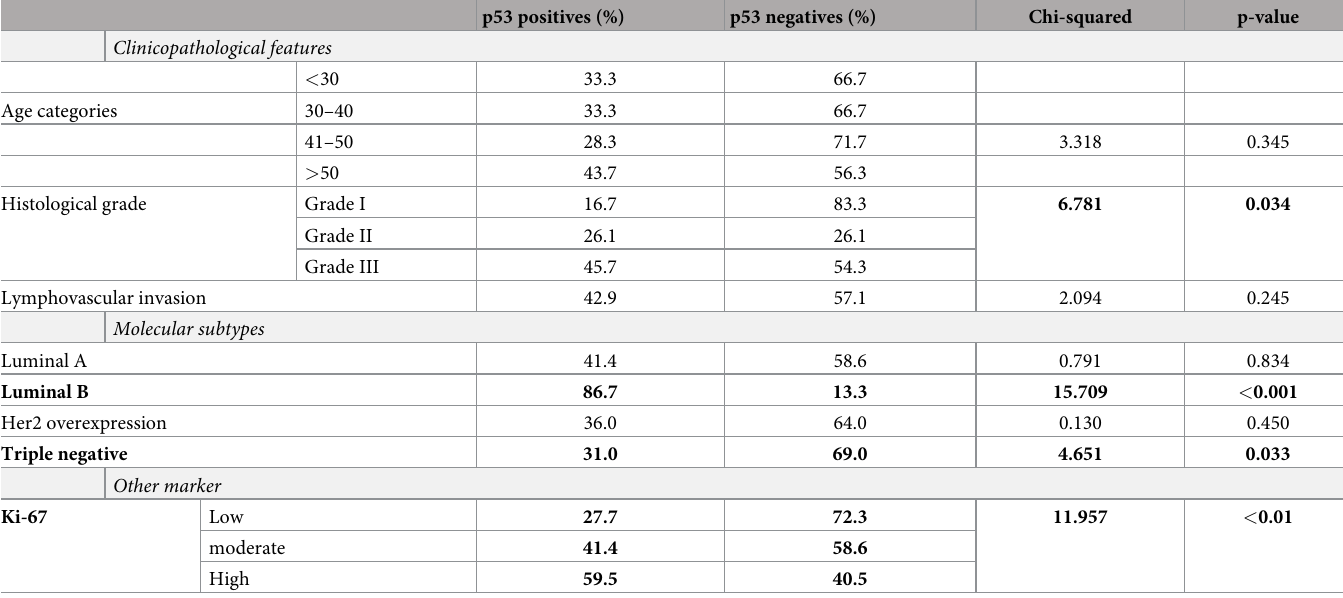
Table 4. Association of p53 with clinicopathological features, molecular subtypes and other biomarkers.